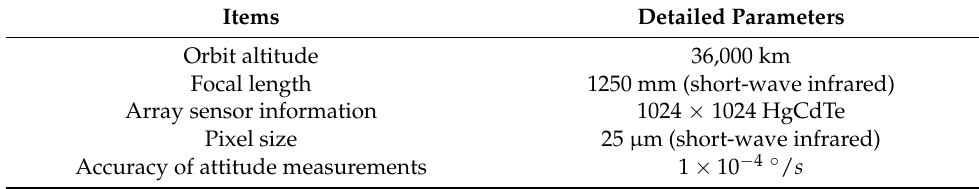
Table 1. Parameters of the experiment satellite.